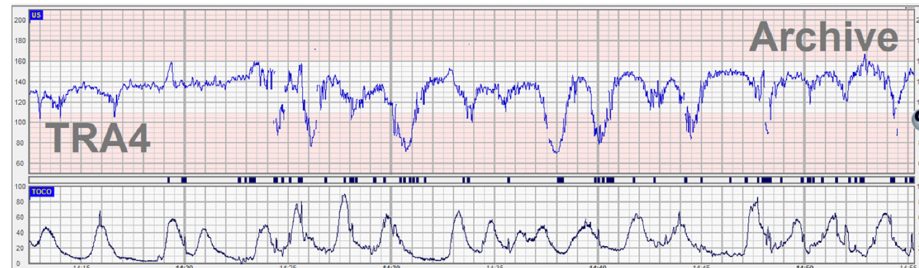
Figure 2. Abnormal CTG (recurrent decelerations) associated with compound cord presentation. A